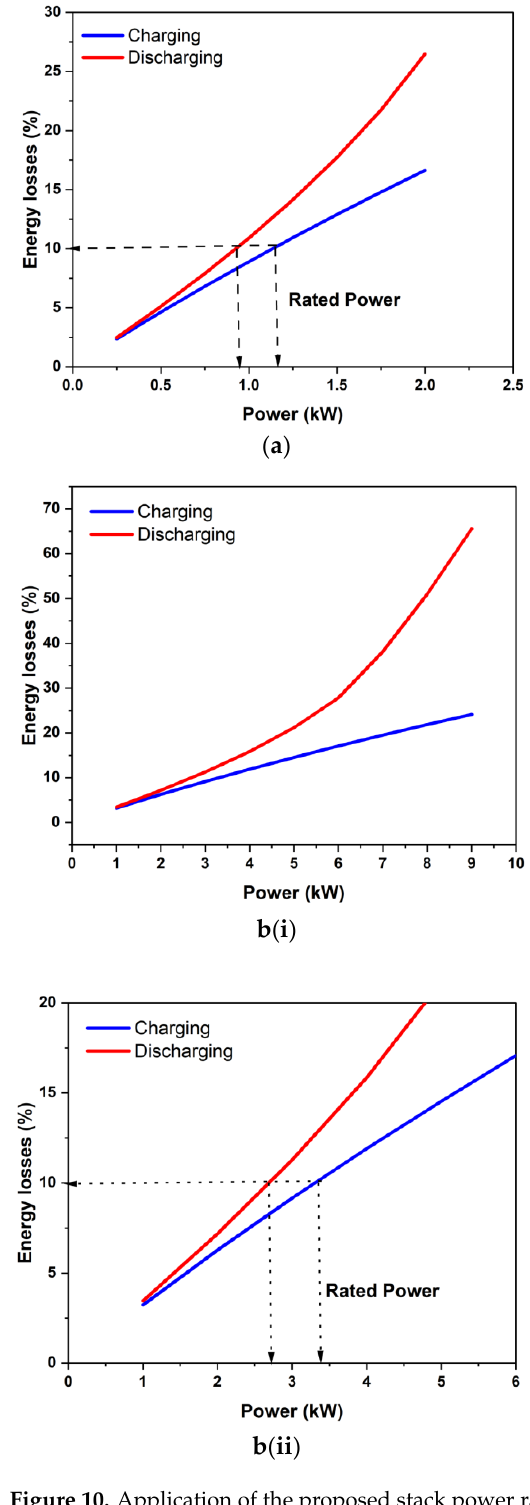
Figure 10. Application of the proposed stack power rating concept to the stacks of ( a ) Zhao et al. [12] and ( b ( i ), b ( ii )) Guarnieri et al. [16]. ( b ( i )) shows the energy loss percentage as a function of operating power while ( b ( ii )) shows the power rating of the stack having loss characteristics shown in ( b ( i )).